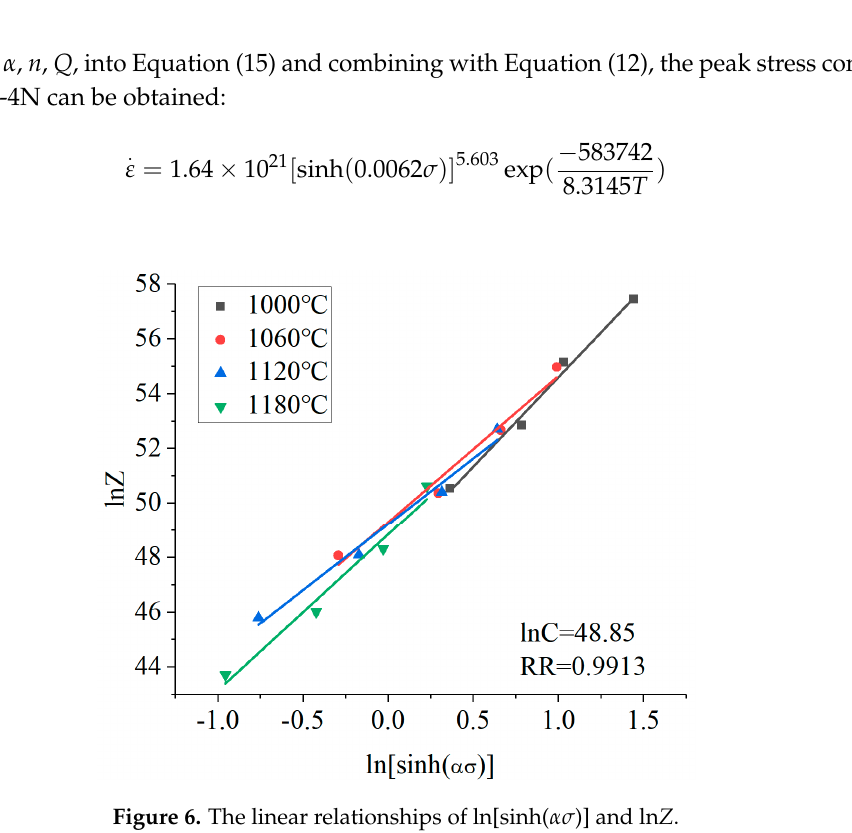
Figure 6. The linear relationships of ln[sinh( ασ )] and ln Z .